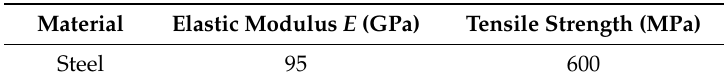
Table 3. Properties of the anchor.